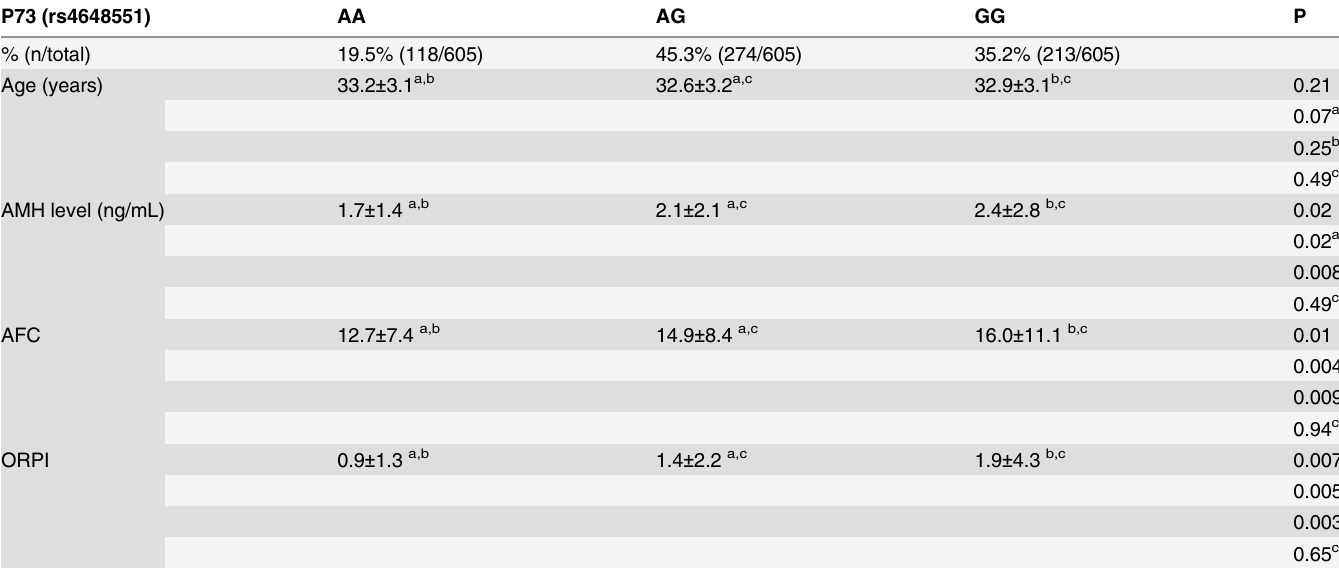
The P value represents the comparison between genotypes: a AA versus AG; b AA versus GG; c AG versus